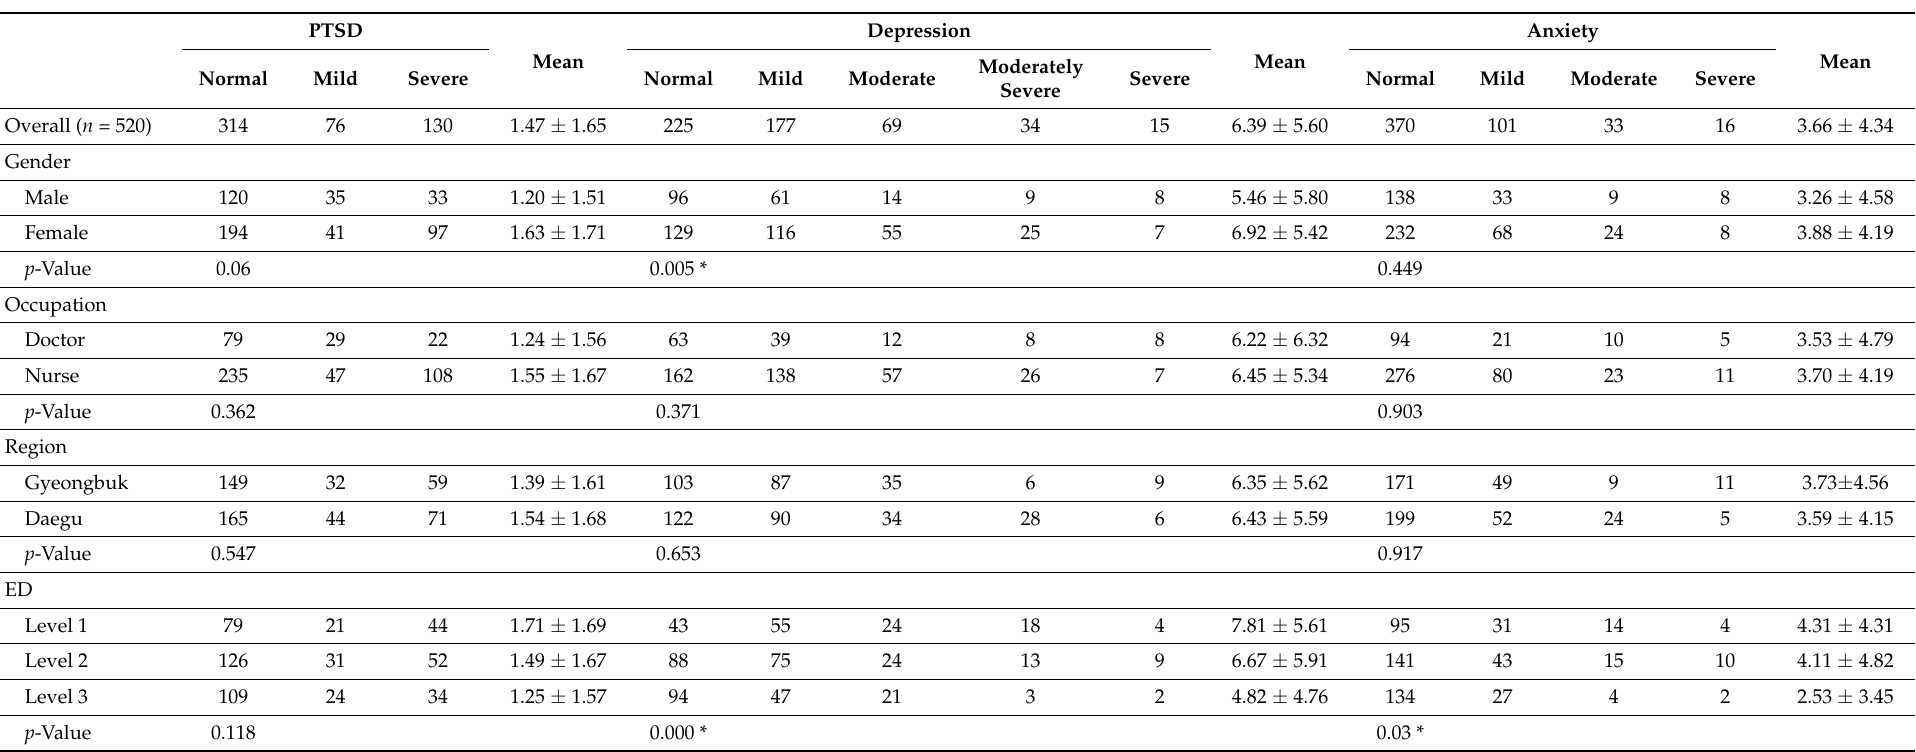
Table 4. PTSD, depression, and anxiety status of